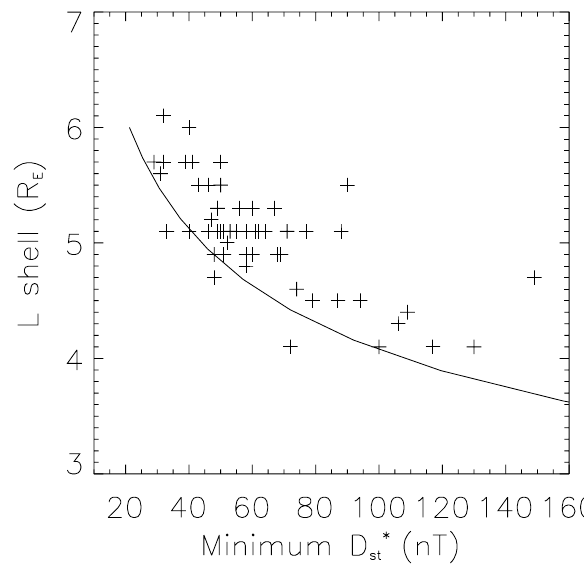
Fig. 2. Correlation between the position of the maximum T (L) in the outer radiation belt during the period of largest flux enhancement with the minimum D st * value of the coin- cident magnetic storm. Results from CID data between Jan- uary 1995 to March 1998. Correlation coefficient = − 0.728584. The curved line is the relationship derived by Tverskaya (1996). | D st | max = 2 . 75 × 10 4 /L 4 max